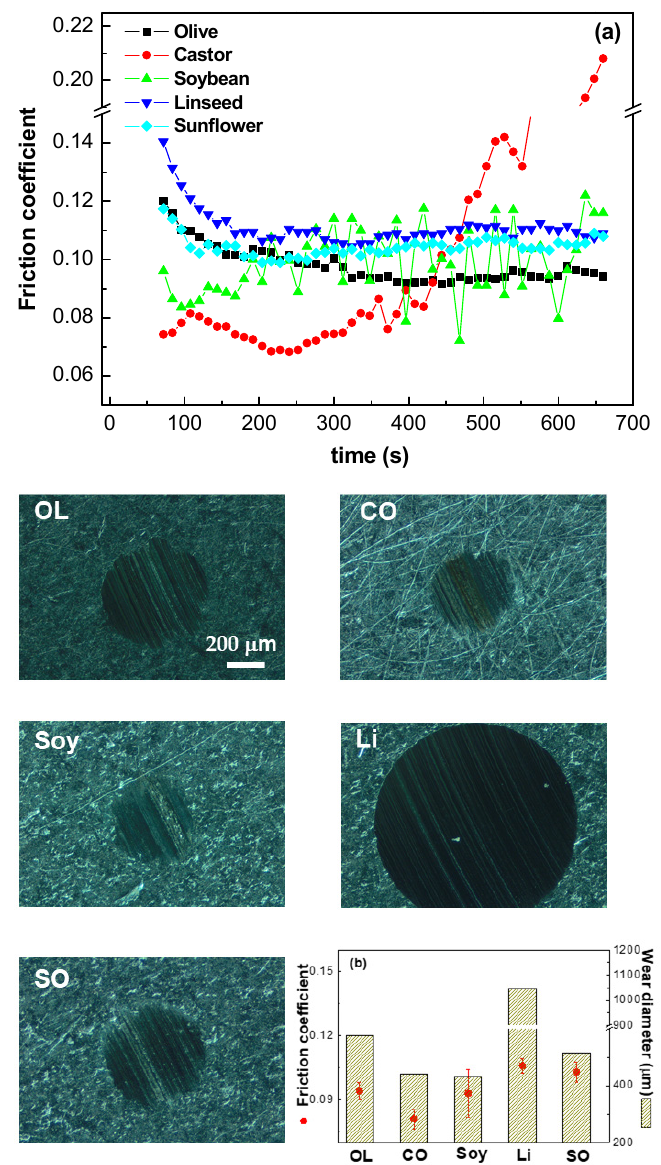
Figure 8. ( a ) Friction curves for oleogels as a function of vegetable oils, and ( b ) Optical images of the worn plate surface and average friction coefficient (points), wear diameter (bars).